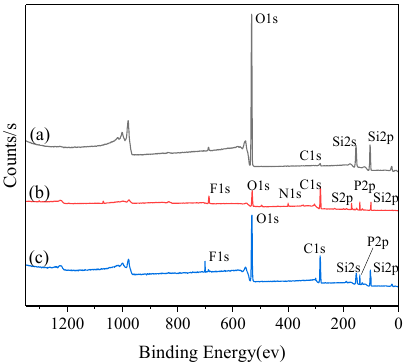
Figure 3. Full-range X-ray photoelectron spectroscopy spectra of SiO 2 -H ( a ), neat IL ( b ), and Si-P 8 TFSI / SiO 2 -H(I) ( c ).